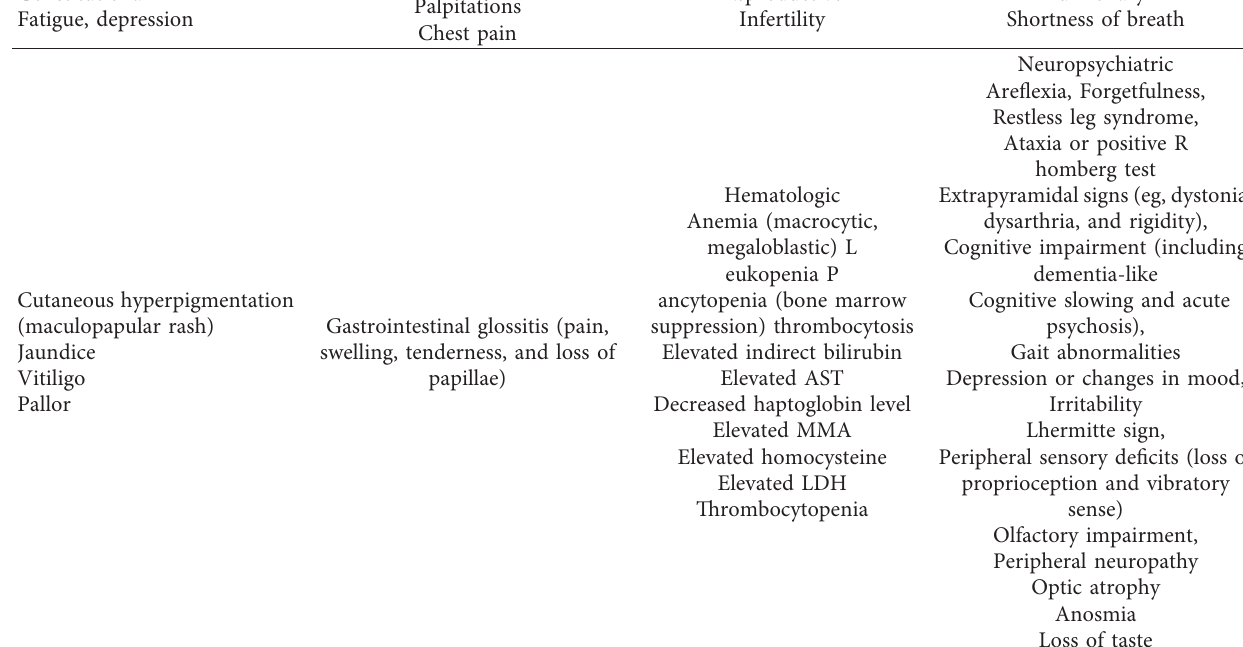
Table 1: A comprehensive list of signs and symptoms associated with vitamin B12 deficiency organized by the organ system.